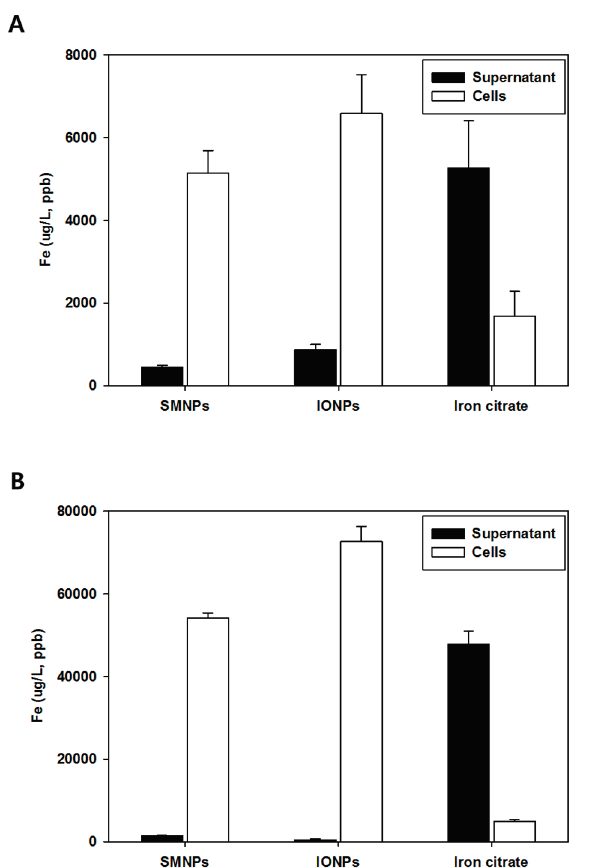
Figure 3. Iron levels of surface-modified nanoparticles (SMNPs), iron oxide nanoparticles (IONPs), and iron citrate in the bone marrow cells and the cell supernatants. The cells were treated with 1% ( A ) and 10% ( B ) iron. SMNPs were prepared by surface modification of the IONPs using a citrate functionalization method